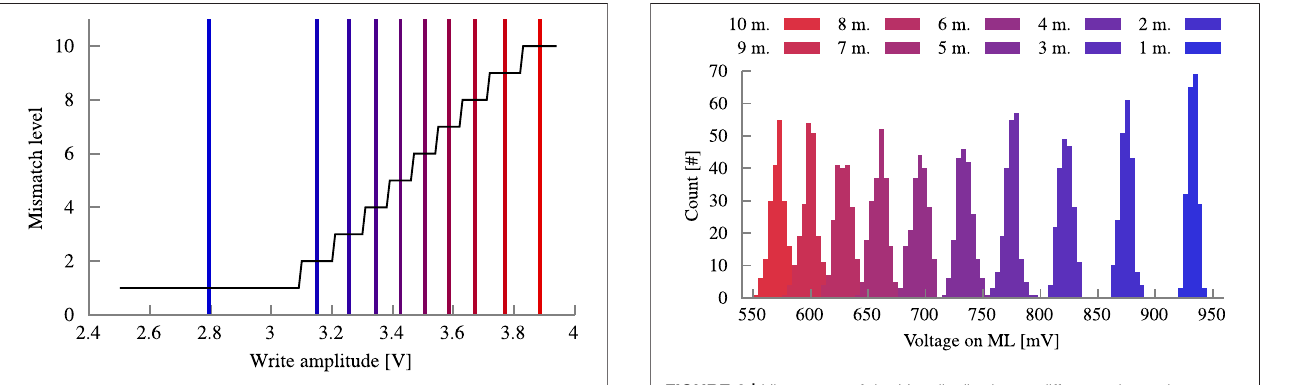
FIGURE 5 | Mapping of the write amplitude to the output Hamming distanceused forcalibration ofthe synaptic comparator. Verticallines indicate the selected amplitudes that maximize